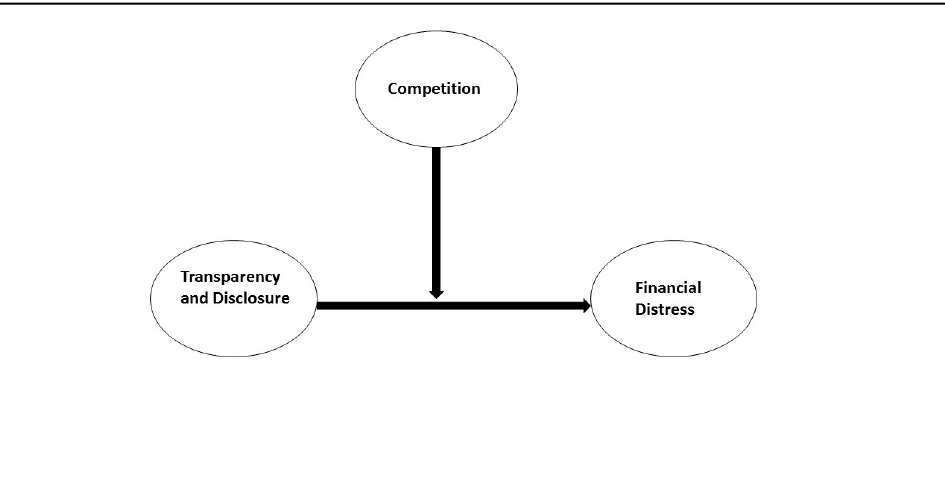
Figure 1. Conceptual